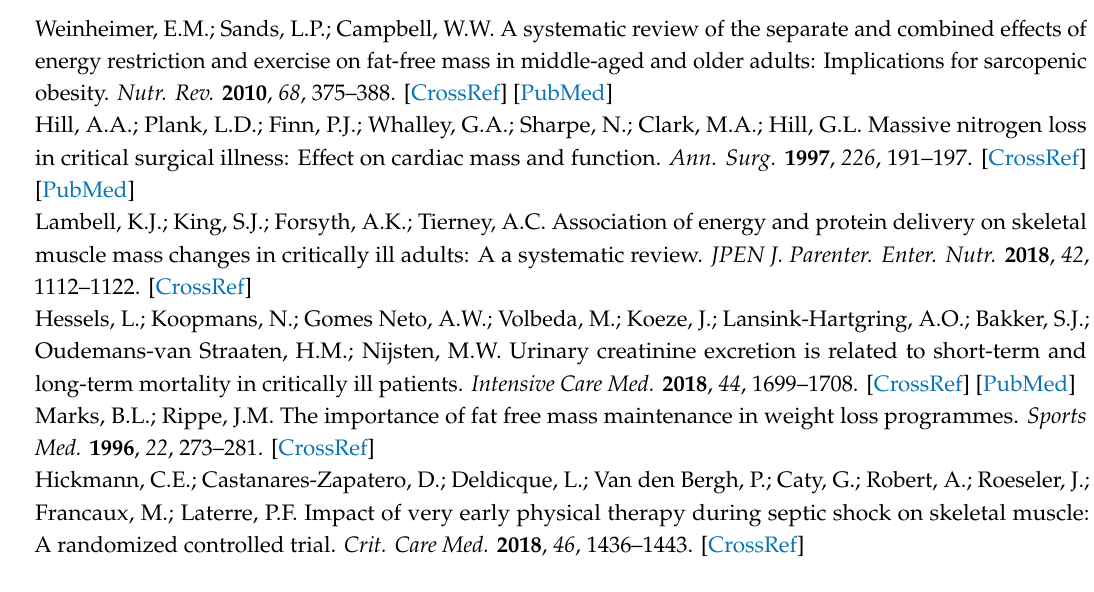
Figure S1: Correlations between changes in signaling and hormones or amino acids for subjects in the sucrose and whey protein groups. Figure S2: Correlations between changes in signaling and hormones or amino acids from PRE to